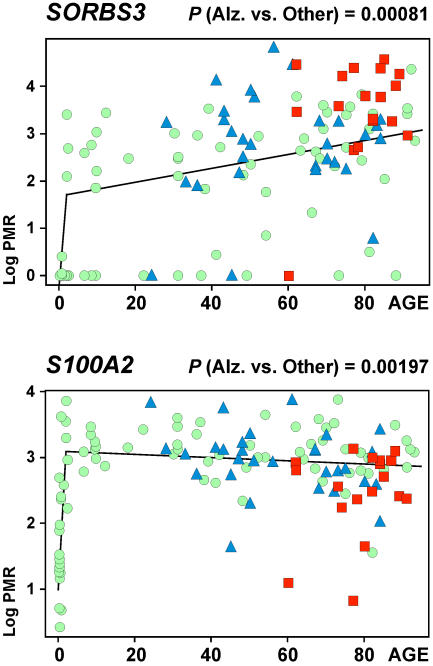
Acceleration of age-associated DNA methylation changes in Alzheimer's disease.Scatter plots showing age-associated methylation changes for SORBS3 and S100A2 across all ages. N = 125 subjects, including Alzheimer subjects (red squares), schizophrenics (blue triangles) and controls (green dots). P-values refer to T-tests for comparison of Alzheimer subjects versus all other subjects older than 60 years. One outlier (ID 2763, 104 years old, Table S4) was omitted from the age-associated analyses.